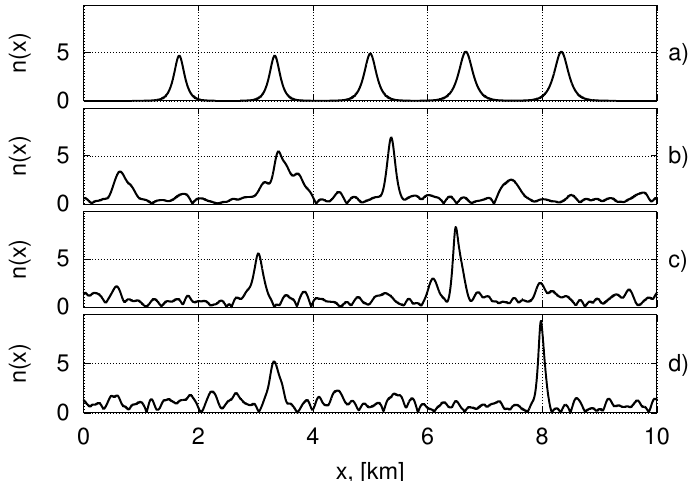
Figure 6. The evolution of five interacting breathers. The ordinate shows the particles number density n ( x ) . The top panel ( a ) presents the initial state ( t = 0 s.). Panels ( b ) and ( c ) correspond to the states with t = 3.49 × 10 5 s. and t = 6.5 × 10 5 s. The lower panel ( d ) presents the state of pre-breaking